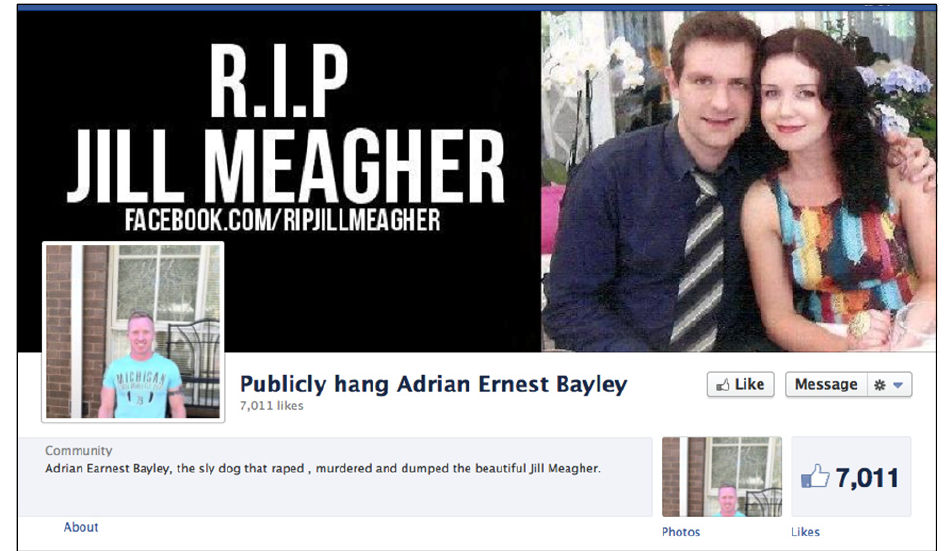
Figure 1: Image of ‘R.I.P Jill Meagher’ Facebook page captured within hours of its